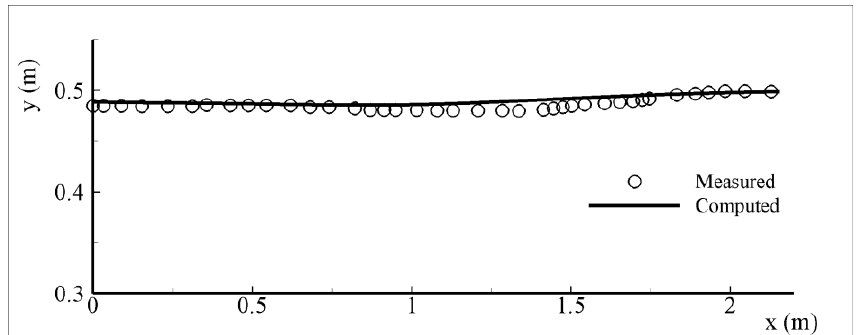
Fig. 3. Comparison of simulated surface elevations with the experimental measurements of Ead and Rajaratnam (2002) (Experiment